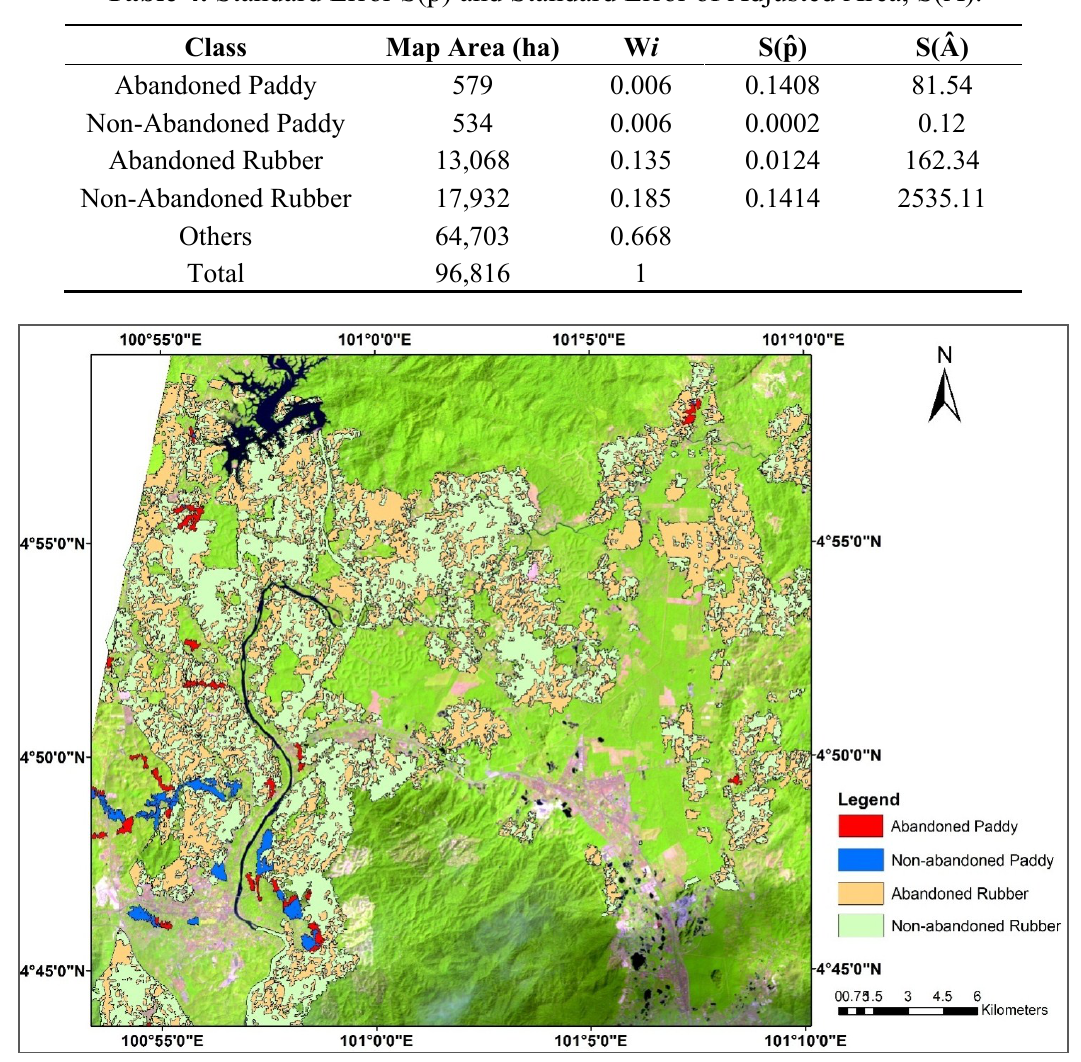
Figure 8. Classification